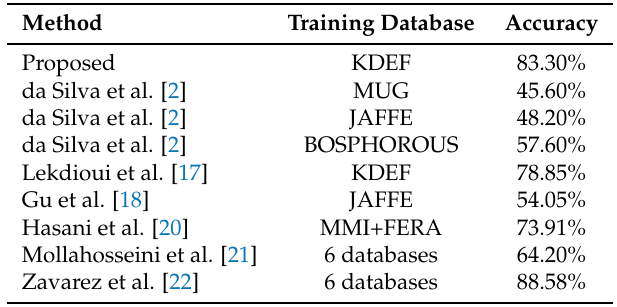
Table 2. Comparison among state-of-the-art cross-database experiments tested on the CK+